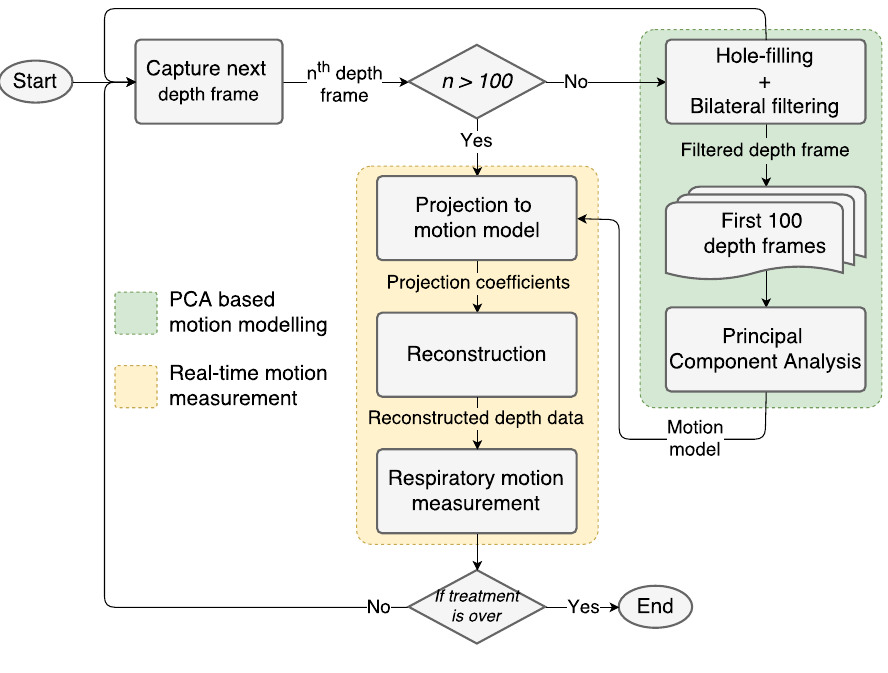
Figure 1. Flowchart of the proposed PCA-based respiratory motion-analyzing system. The first 100 depth frames are used to generate a PCA-based respiratory motion model. Then, that model (principal components) is used for real-time respiratory motion measurement starting from the 101st